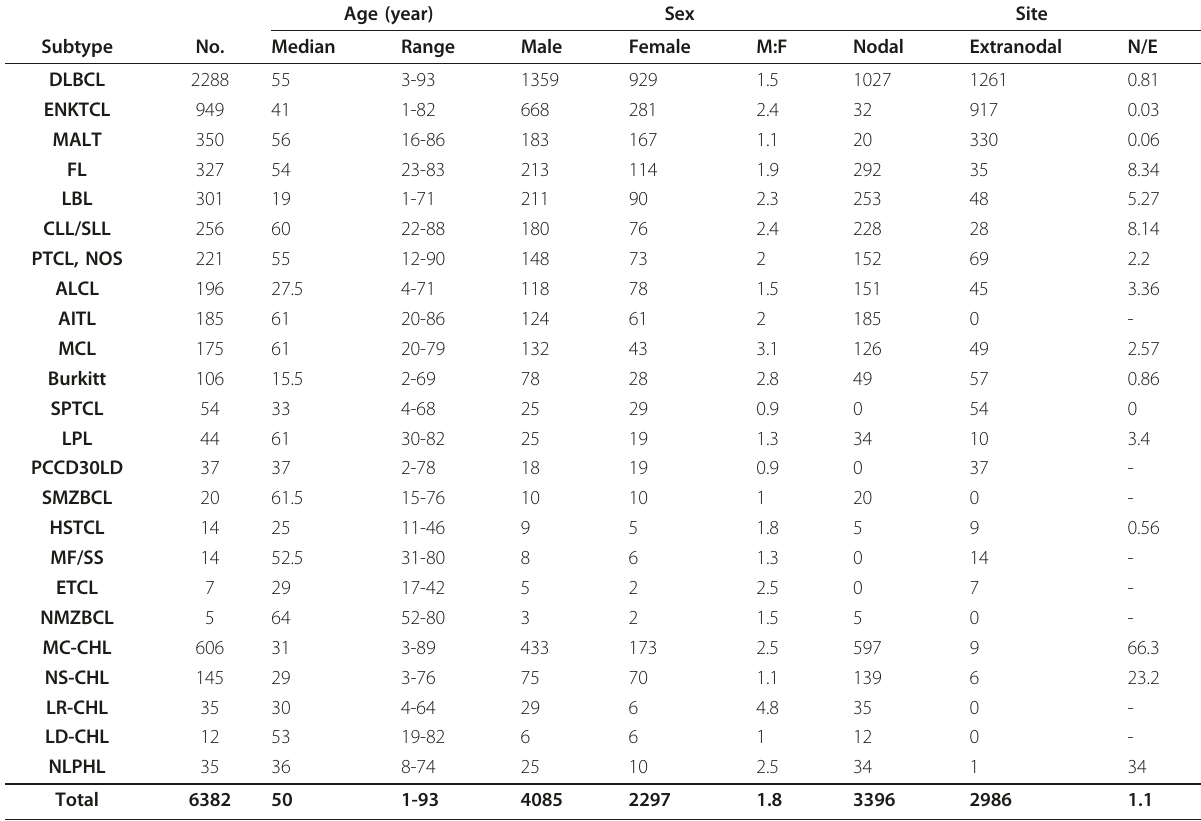
Table 1 Subtypes of lymphomas (n =